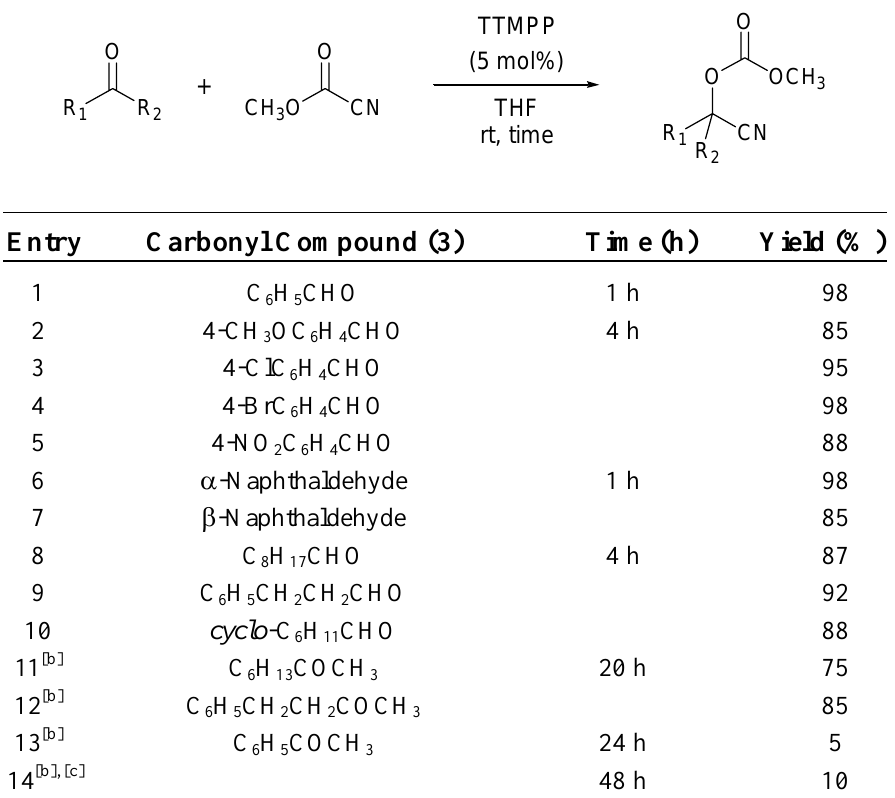
Table 3. TTMPP-Catalyzed cyanocarbonation of aldehydes and ketone.